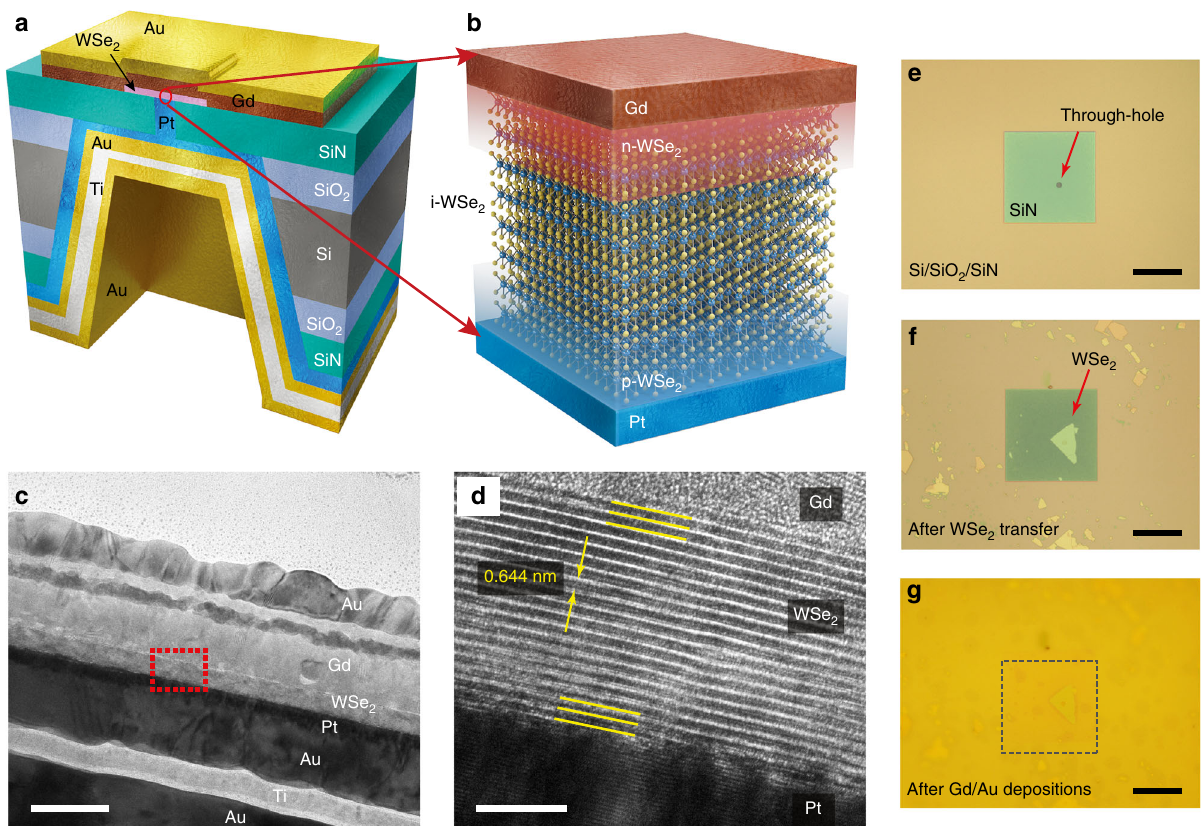
Fig. 1 Schematics and viewgraphs of vertical WSe 2 diodes. a Schematic of vertical WSe 2 diodes fabricated on a SiN membrane with a through-hole of 3 μ m in diameter. True vertical p – i – n heterojunctions in homogeneous 2D vdW materials are formed through the depositions of Gd and Pt fi lms on each facet of WSe 2 fl akes. Oxidation-prone Gd and Pt fi lms are protected by Au fi lms, and sputtered Ti and Au metals fi ll the void on the backside of the Si/SiN